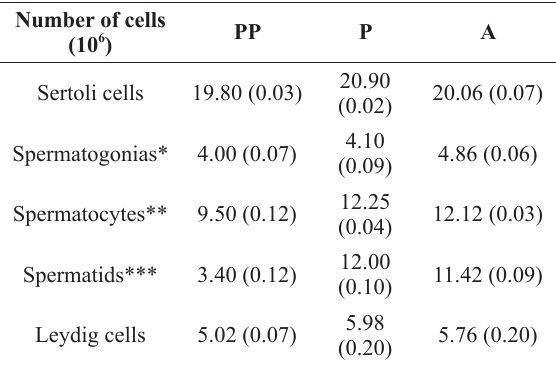
The mean values of the total number of Sertoli cells, spermatogonia, spermatocyte, spermatid and Leydig cells in guinea pig.